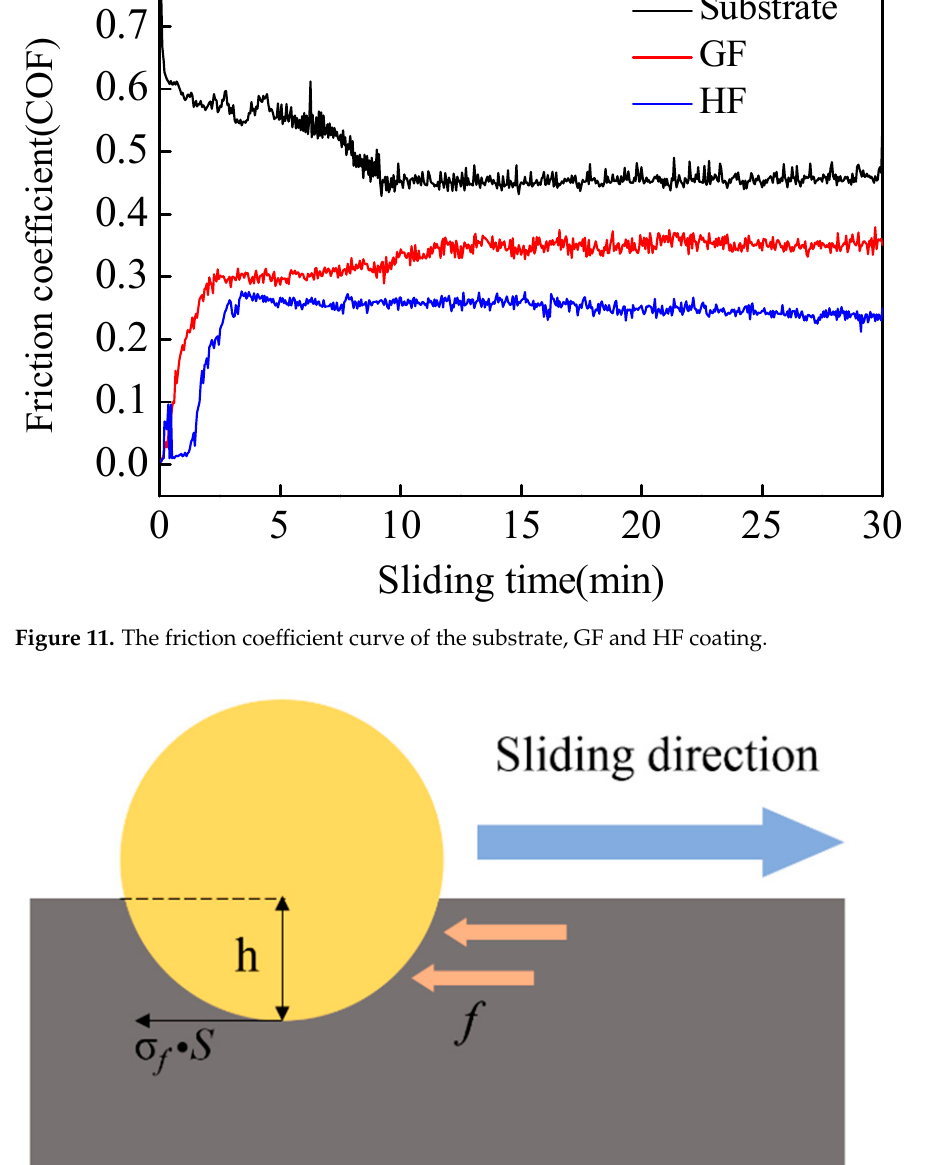
Figure 12. Forces on the GCr15 ball and substrate during the friction and wear experiment. In comparison, the wear curves of the HF and GF coatings and the 27SiMn steel substrate are quite different. In the initial stage of wear, the friction coefficients rapidly increase from 0 to 0.27 and 0.30, respectively. The coating with higher hardness makes the pressing depth of the grinding ball shallow, resulting in less resistance f to the grinding ball during the friction stage. Through the cyclic wear of the grinding ball on the surface of the substrate, the contact area between the grinding ball and the surface of the substrate gradually becomes smooth, so the friction coefficient gradually increases. Finally, the COF of the HF and GF coatings stabilized at around 0.23 and 0.37, respectively. Due to the surface peeling and wear of the coating during the friction process, the COF will fluctuate, but the friction curve of the HF coating is the most stable. The wear volume of the 27SiMn steel substrate, the HF and GF coatings is shown in Figure 13. It can be noted that the HF coating has the lowest wear volume. The wear volume of the HF coating and the